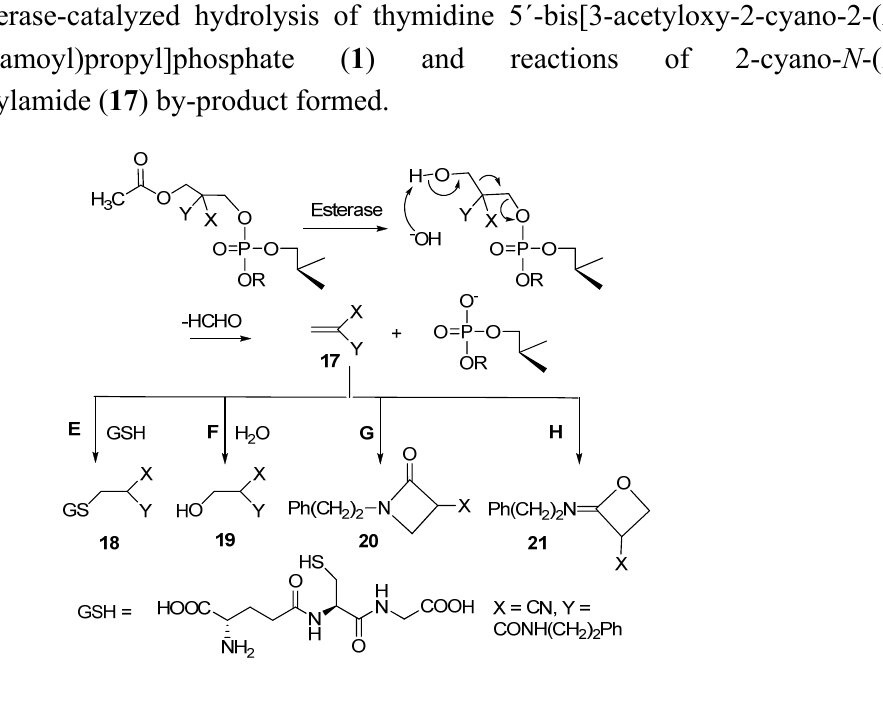
and reactions of 2-cyano- N -(2-